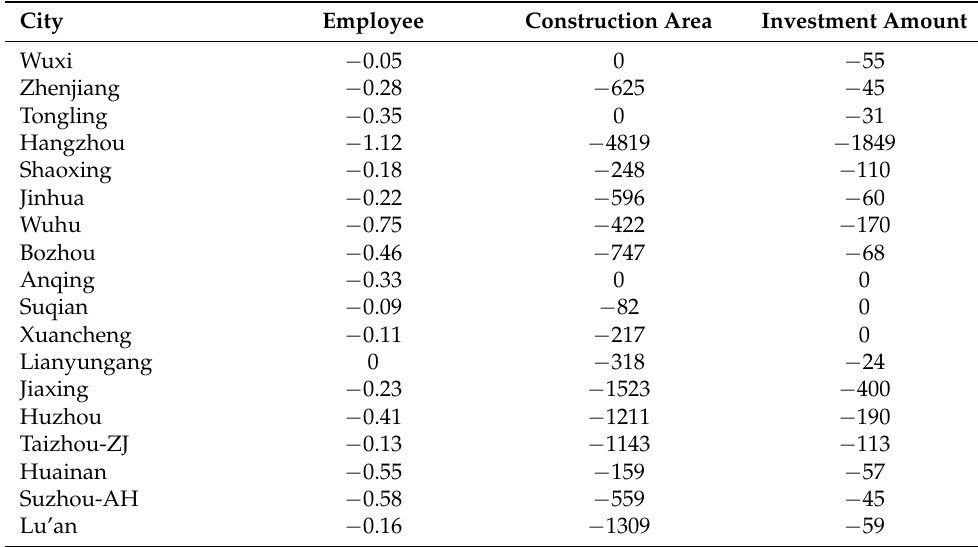
Table 7. The input management suggestions of real estate inventory in the Yangtze River